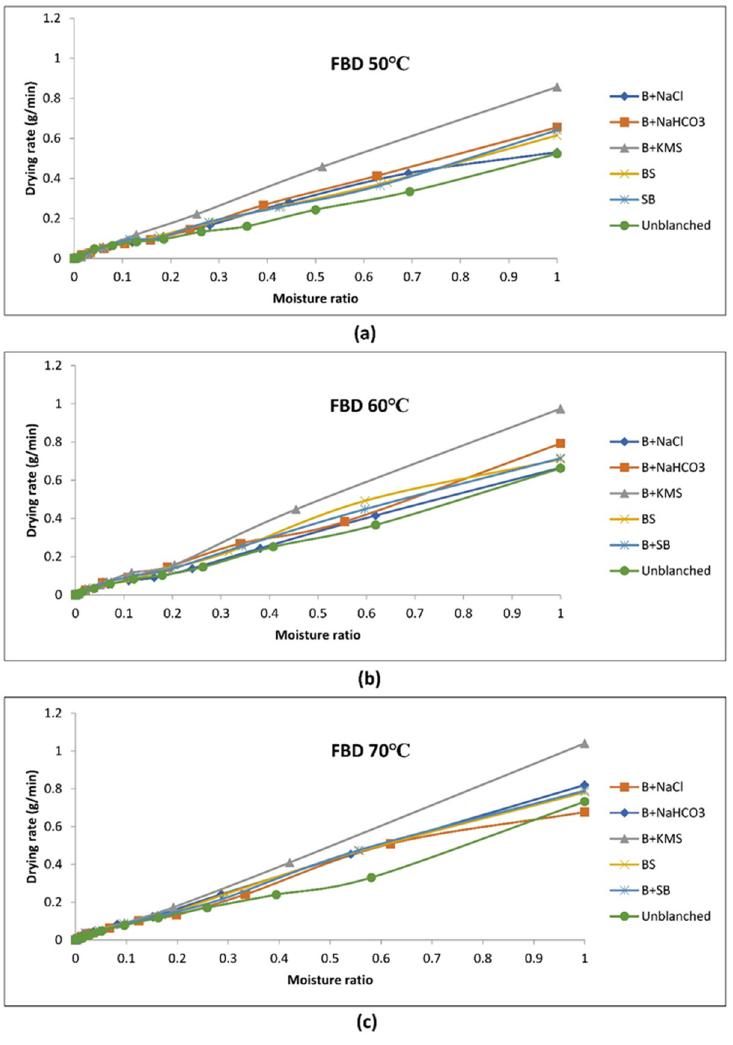
Figure 2. ( a – c ): Drying rate versus moisture ratio (MR) curves as influenced by pretreatments under fluidized bed drying (FBD) at 50 °C ( a ), 60 °C ( b ) and 70 °C ( c ).